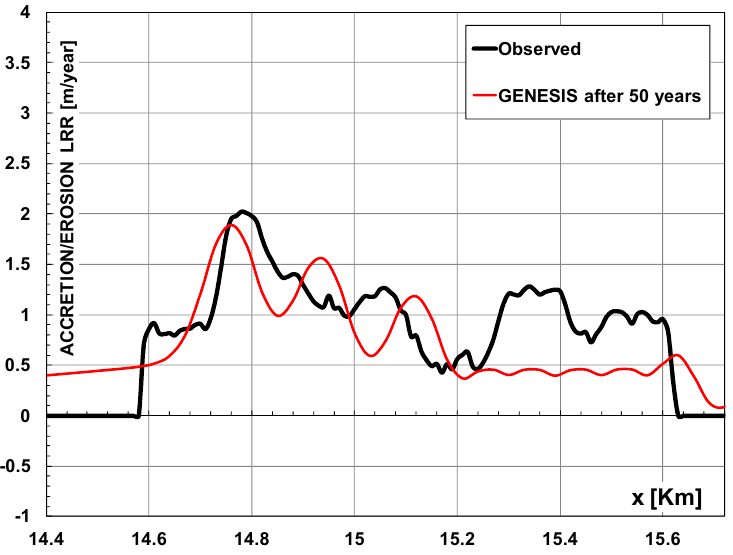
Figure 12. Observed vs. numerical shoreline change rate at A2.